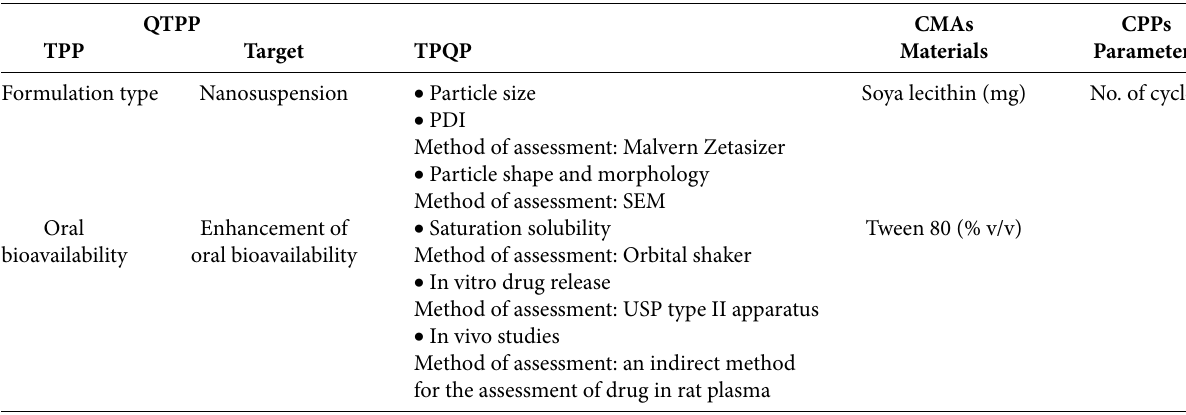
Table 1. Study target with CMAs and